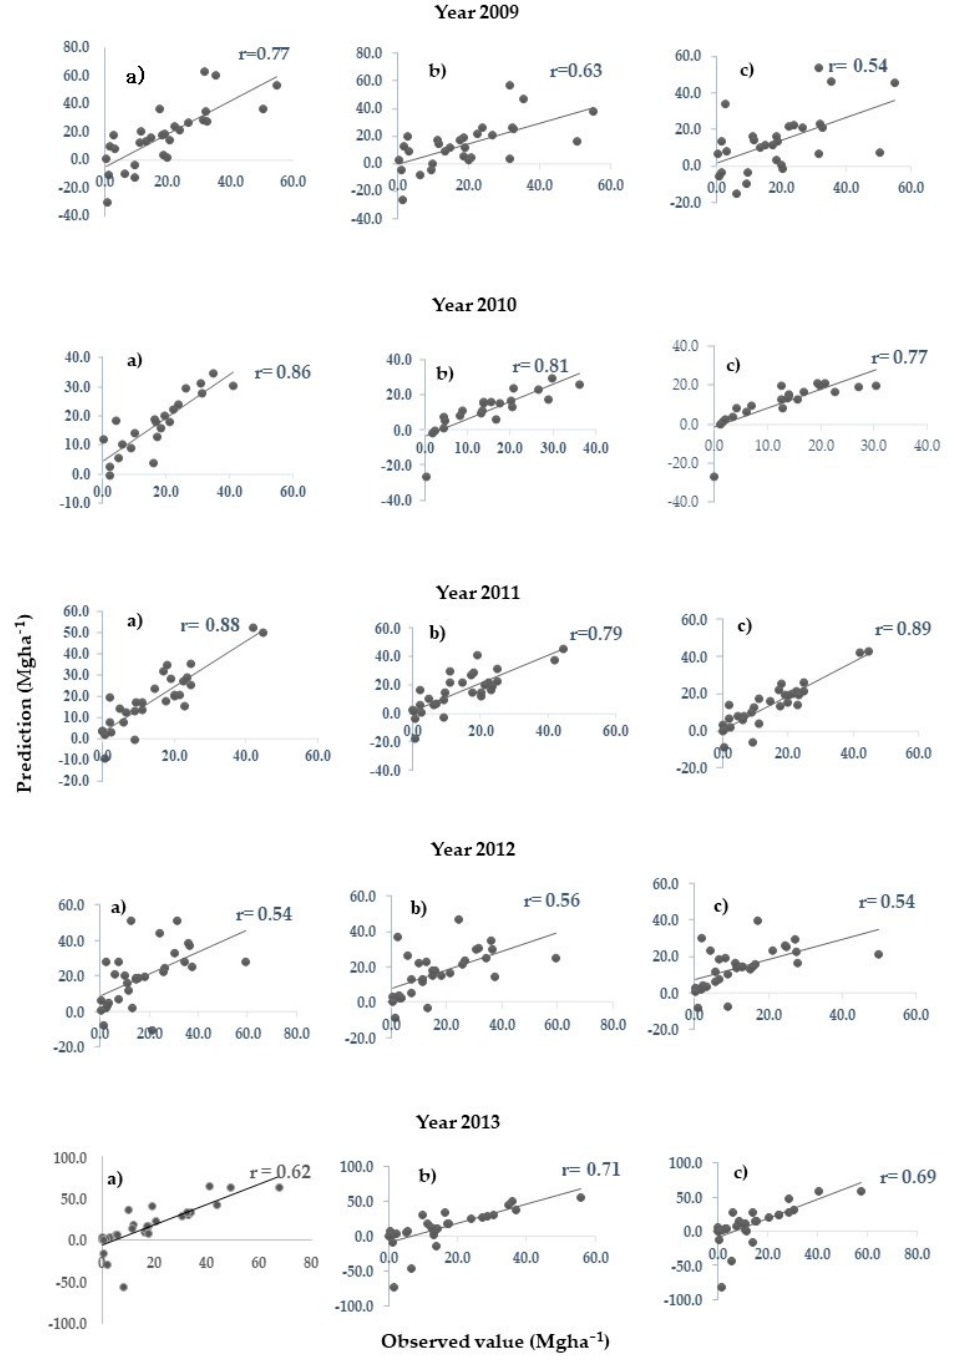
Figure 3. Relationship between estimated fuel load in conglomerates and that obtained by prediction with the partial least squares regression model with CMP factor analysis for the models. Subfigures ( a ) real stock, ( b ) aboveground biomass; and ( c ) coniferous